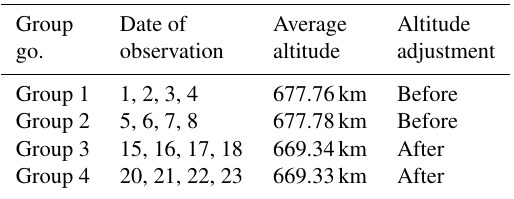
Table 1. Grouping information of the data from 1 to 23 Jan- uary 2006. Group Date of Average Altitude go. observation altitude adjustment Group 1 1, 2, 3, 4 677.76km Before Group 2 5, 6, 7, 8 677.78km Before Group 3 15, 16, 17, 18 669.34km After Group 4 20, 21, 22, 23 669.33km